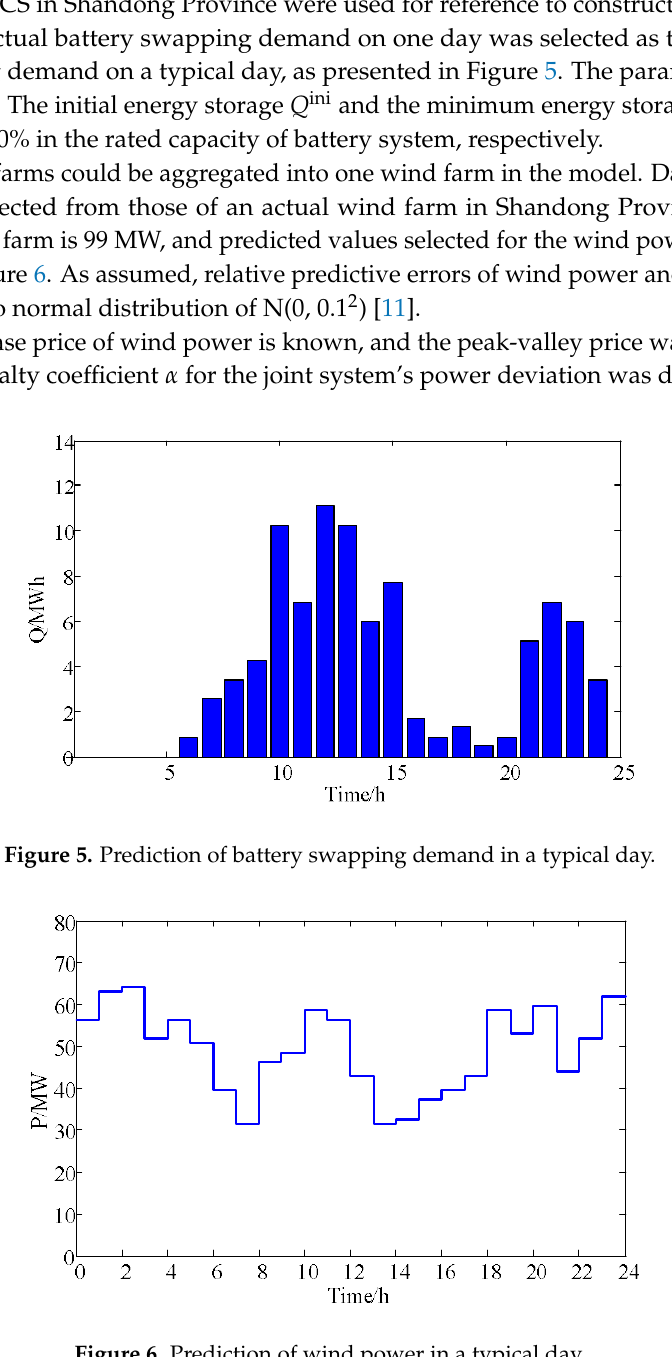
Figure 7. Pool purchase price of wind power.